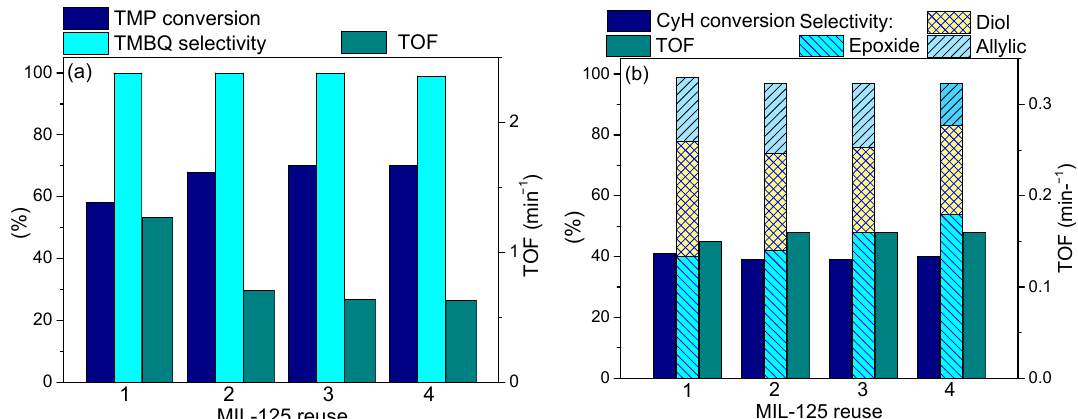
Figure 9. Reuse of MIL-125 in ( a ) TMP oxidation with H 2 O 2 and ( b ) CyH oxidation with H 2 O 2 in the presence of 1 equiv. of HClO 4 .